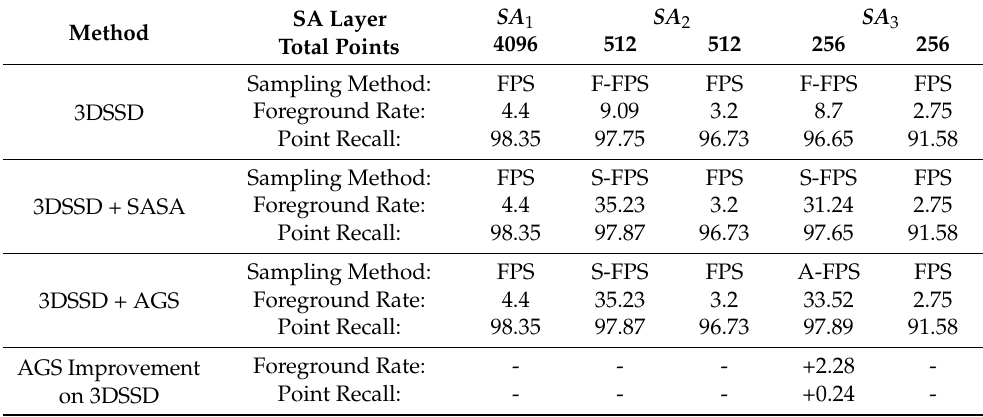
Table 4. Analysis of point sampling by layer on 3DSSD, evaluated on the car class of KITTI val split. The level 2 and level 3 SA layers exploit the fusion sampling strategy to individually sample half the key points with two different sampling